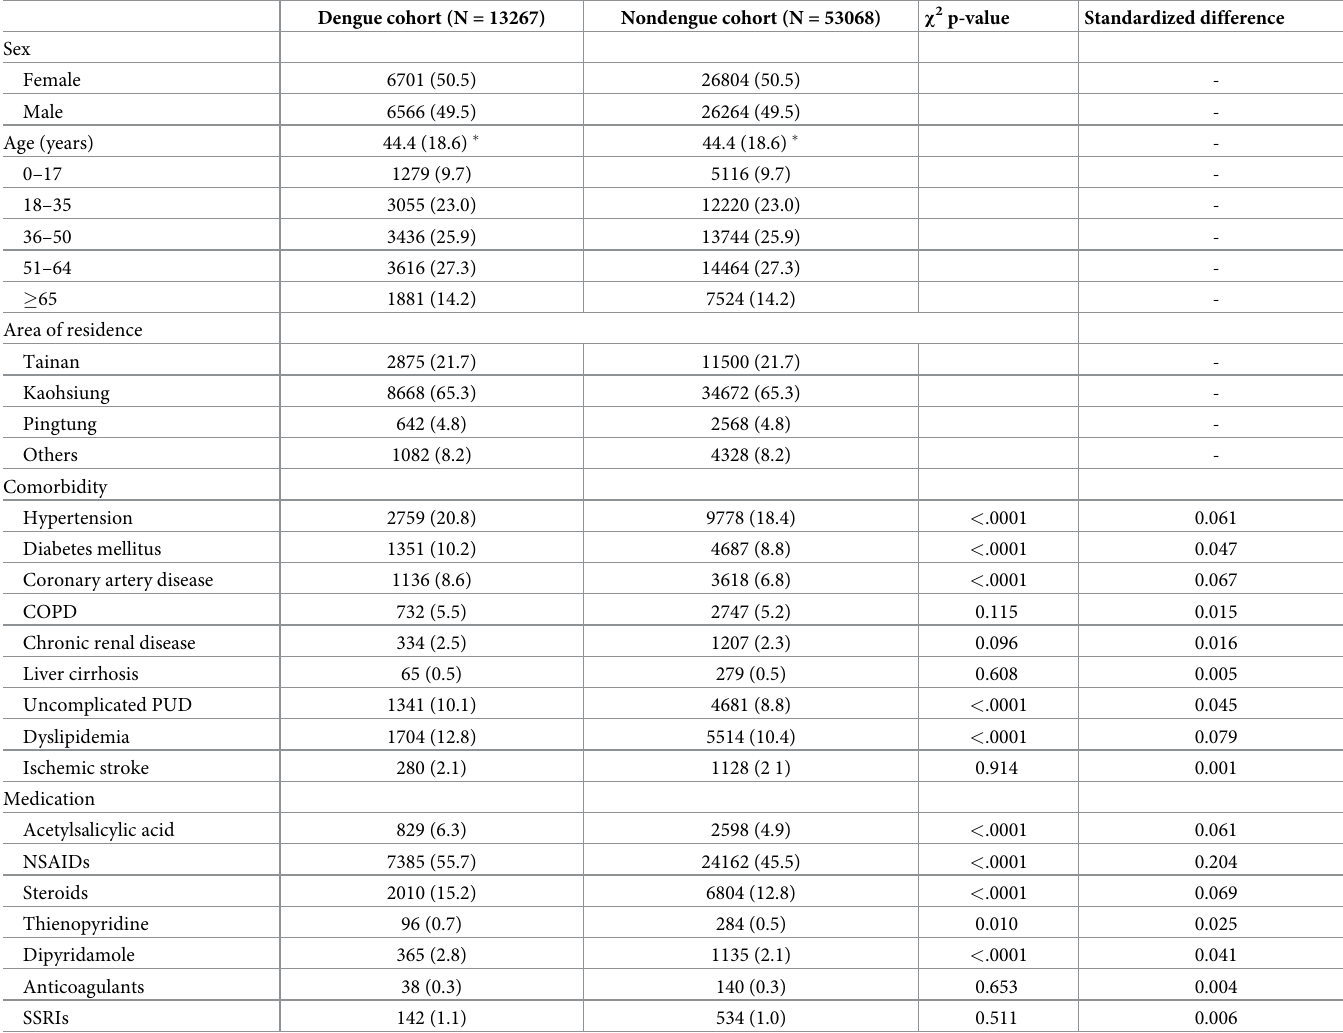
Table 1. Demographic and clinical characteristics in the dengue and nondengue